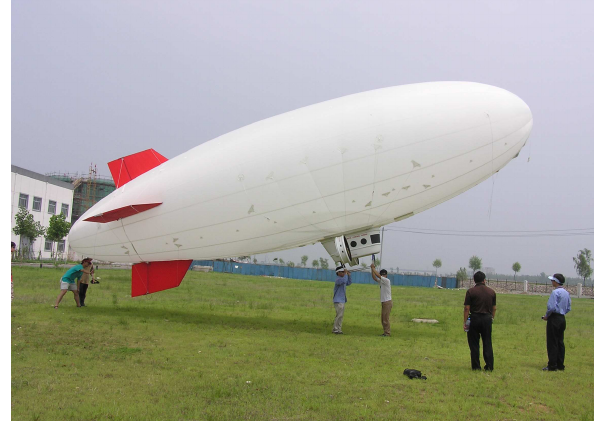
Figure 2: He-Blimp of the University Beijing with a stabilised platform as a carrier for a mid format aerial metric camera (Rollei AIC).